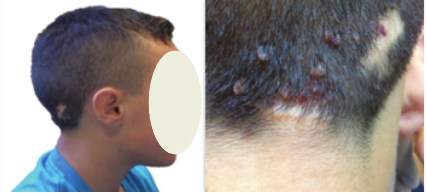
Figure 1: Dolichocephaly and retronuchal angiomas.